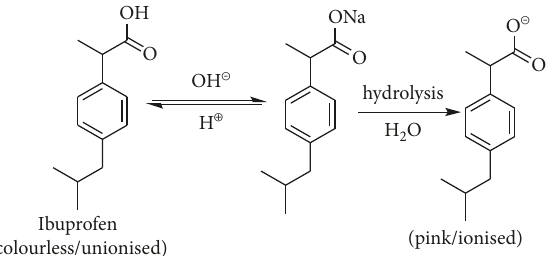
Figure 4: Various proposed forms of ibuprofen under acidic and alkaline conditions.